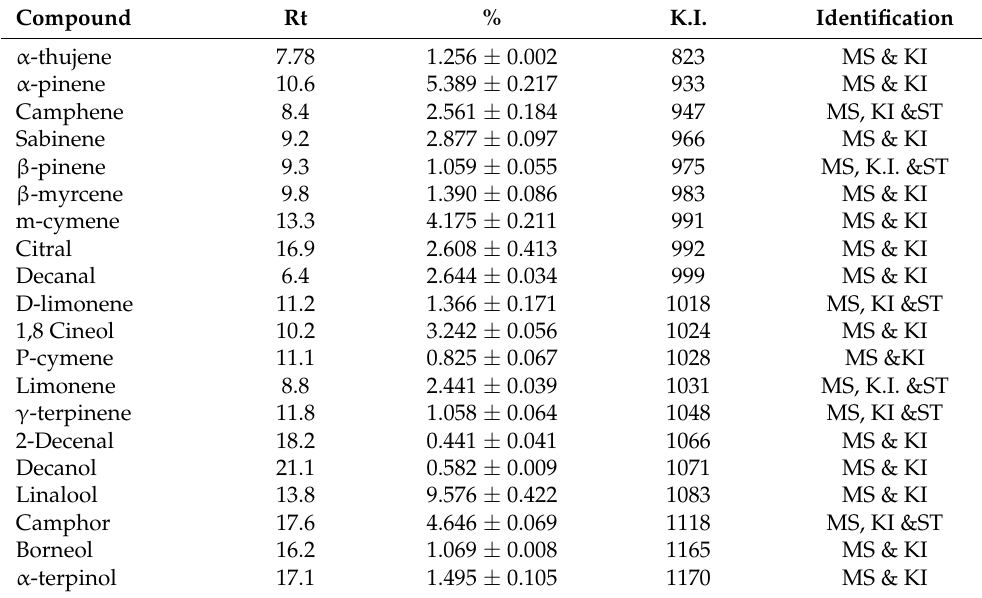
Table 1. Identification of Aromatic compounds in the extract of (ginger:thyme: coriander) mixture by